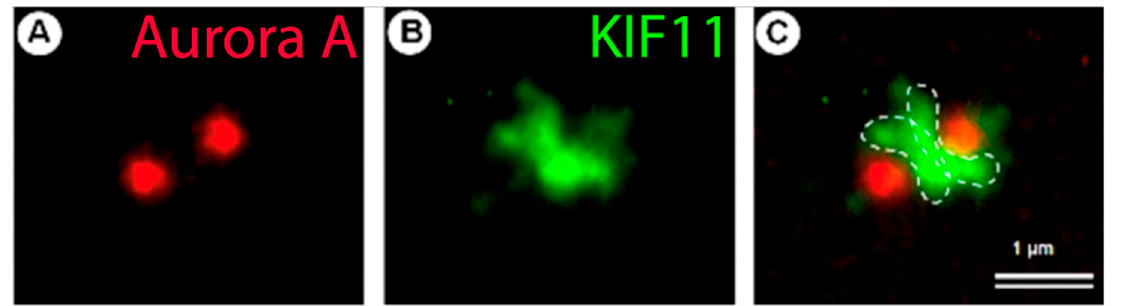
Figure 6. Kinesin-like motor KIF11 participate in centrosome separation in G2 phase of cell cycle. ( A ) Centrosomes labeled with monoclonal antibodies against Aurora A are shown in red, ( B ) localization of KIF11 between two centrosomes at the beginning its separation was detected with labelling by polyclonal antibodies against KIF11 in green; ( C ) double labelling show superposition. The dotted lines show the probable binding regions of the KIF11 protein to microtubules extending from two centrosomes. Scale bar 1 µm. Photos made by R. Uzbekov from [76] with modifications.